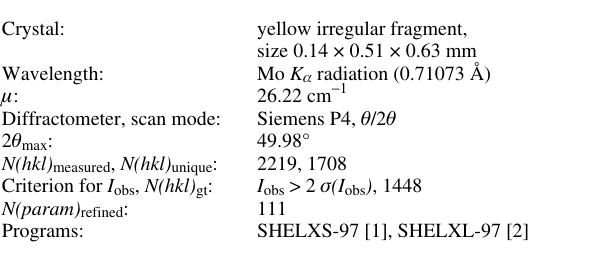
Table 1. Data collection and handling.